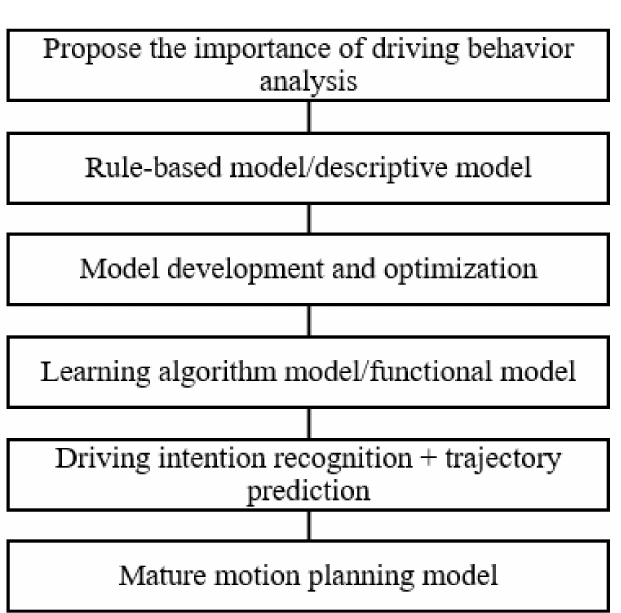
Figure 1. Research course of motion planning model of individual